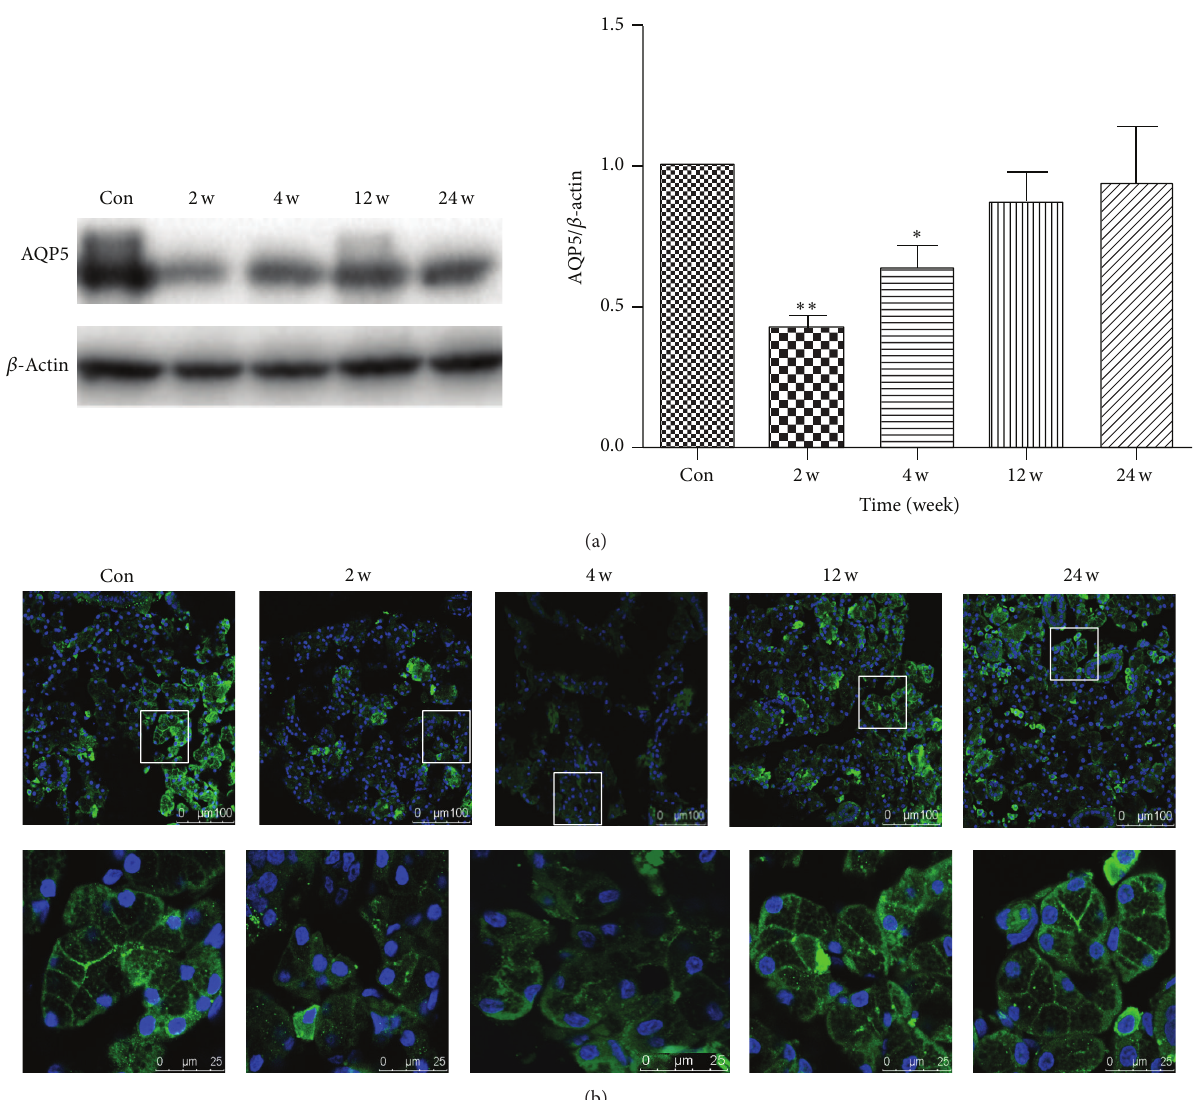
Figure 5: (a): Effect of BTXA on AQP5 expression in transplanted submandibular glands. Con: control group. ∗∗ 𝑝 < 0.01 and ∗ 𝑝 < 0.05 versus control group; (b) effect of BTXA on AQP5 distribution in transplanted submandibular glands. Immunofluorescent localization of AQP5 (green) in control and BTXA-treated transplanted submandibular glands (2 w, 4 w, 12w, and 24 w), with the boxed areas in the top panels (scale bar, 100 𝜇 m) presented at higher magnification in the bottom panels (scale bar, 25 𝜇 m). Nuclei were stained with DAPI